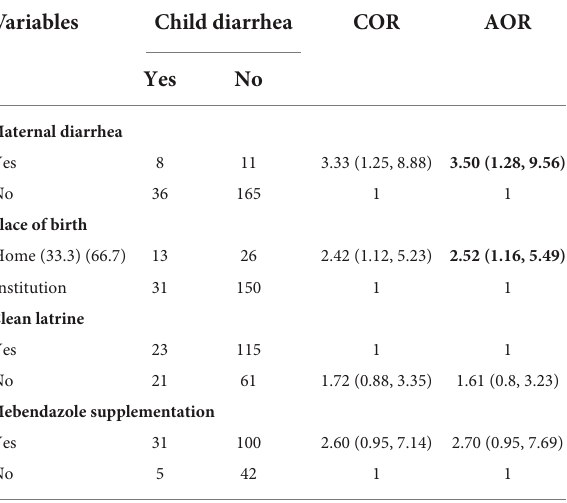
TABLE 5 Independent factors associated with childhood diarrhea among non-model households (HHs) of respondents in Jawi district, Awi Zone, southwest Ethiopia,